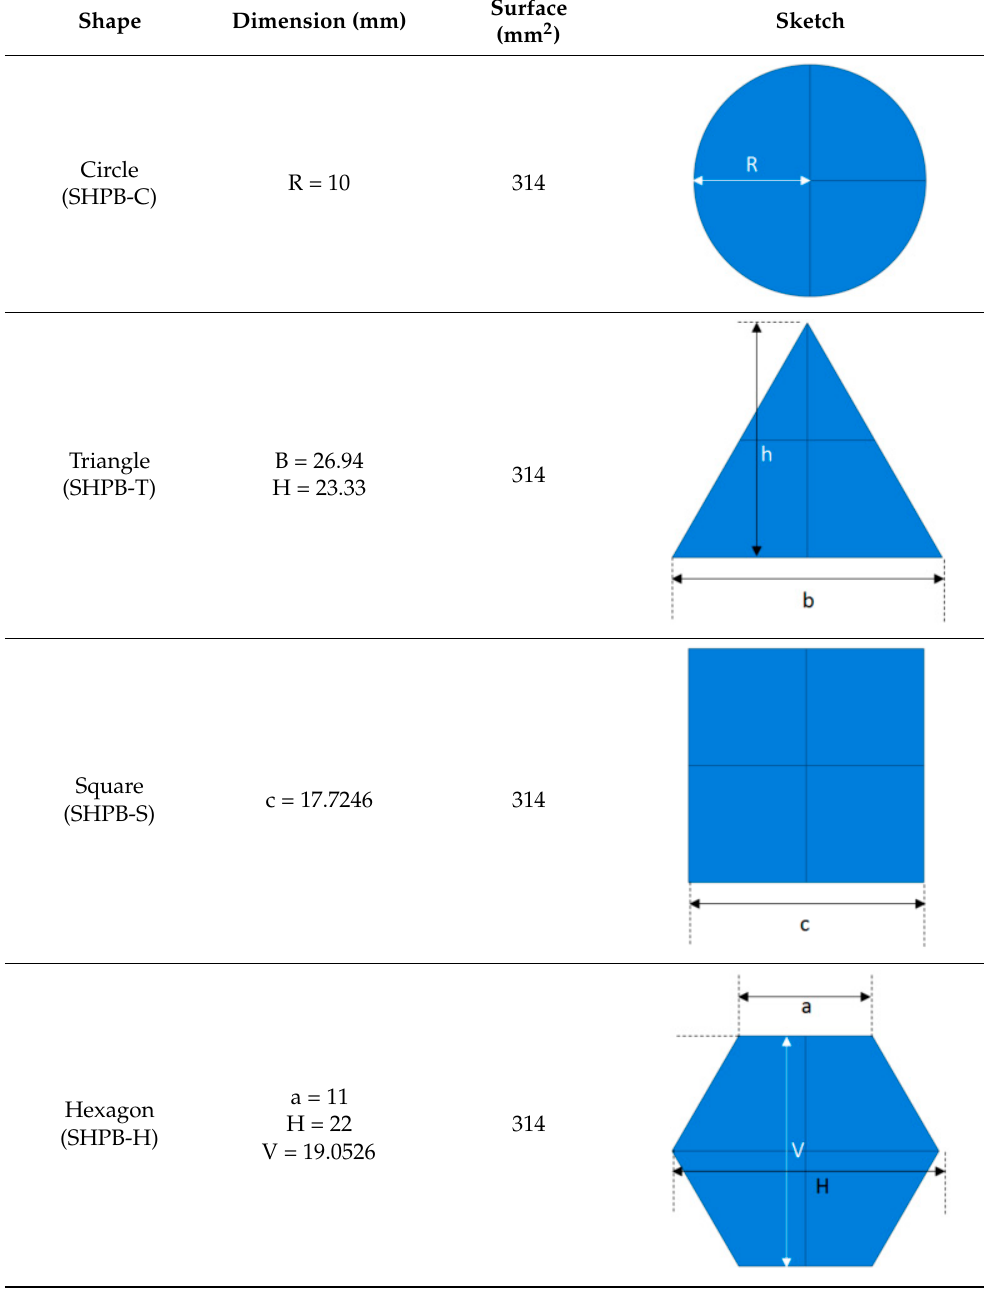
Table 4. Characteristics of the analysed geometries: input bar, output bar, and striker.